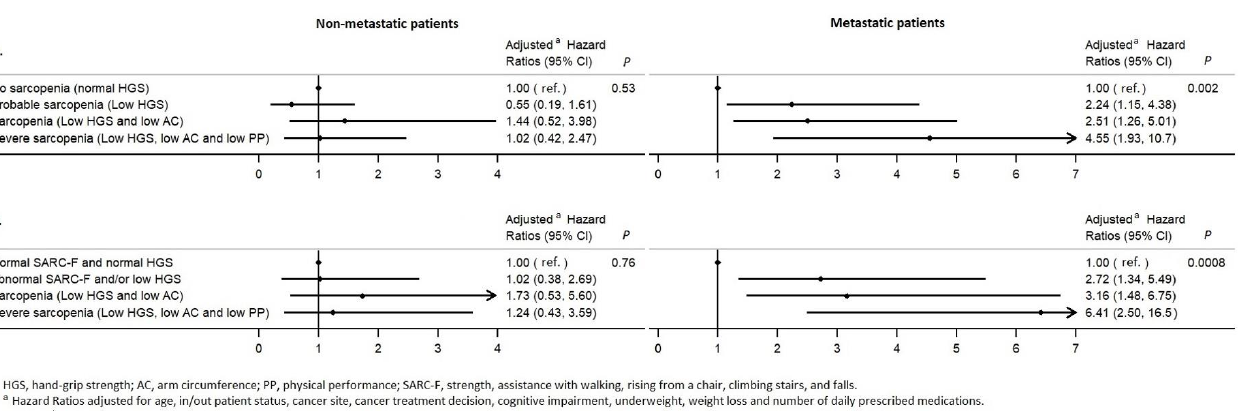
Figure 3. Multivariate Cox analyses of the association between two composite variables for sarcopenia and 6-month mortality, by metastatic status: ( A ). A composite variable corresponding to the EWGSOP2 definition of sarcopenia; ( B ). A composite variable that included the SARC-F in the definition.